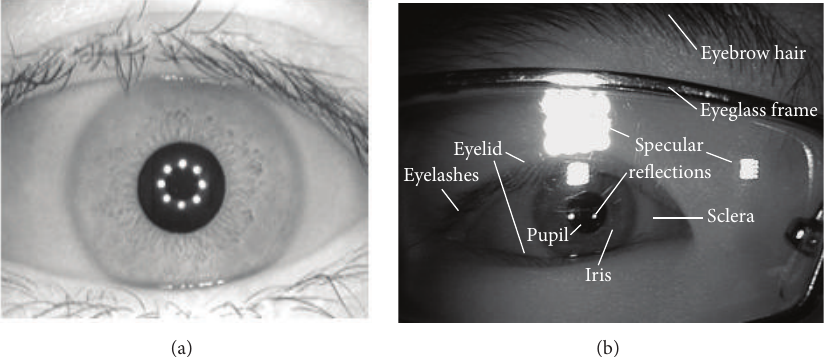
Figure 1: (a) An ideal close-up iris image from CASIA-Iris-Interval, version 3.0; (b) a noisy and non-close-up iris image from CASIA-Iris- Thousand, version 4.0